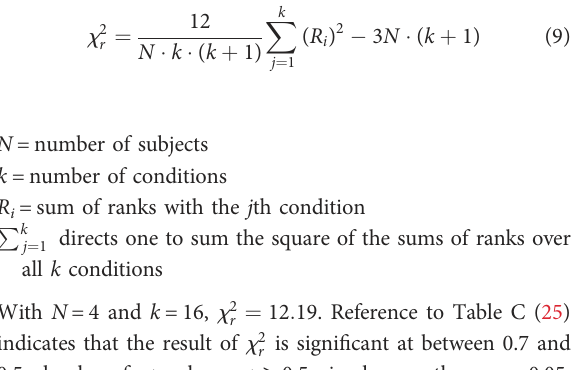
With N = 4 and k = 16, x 2 indicates that the result of x 2